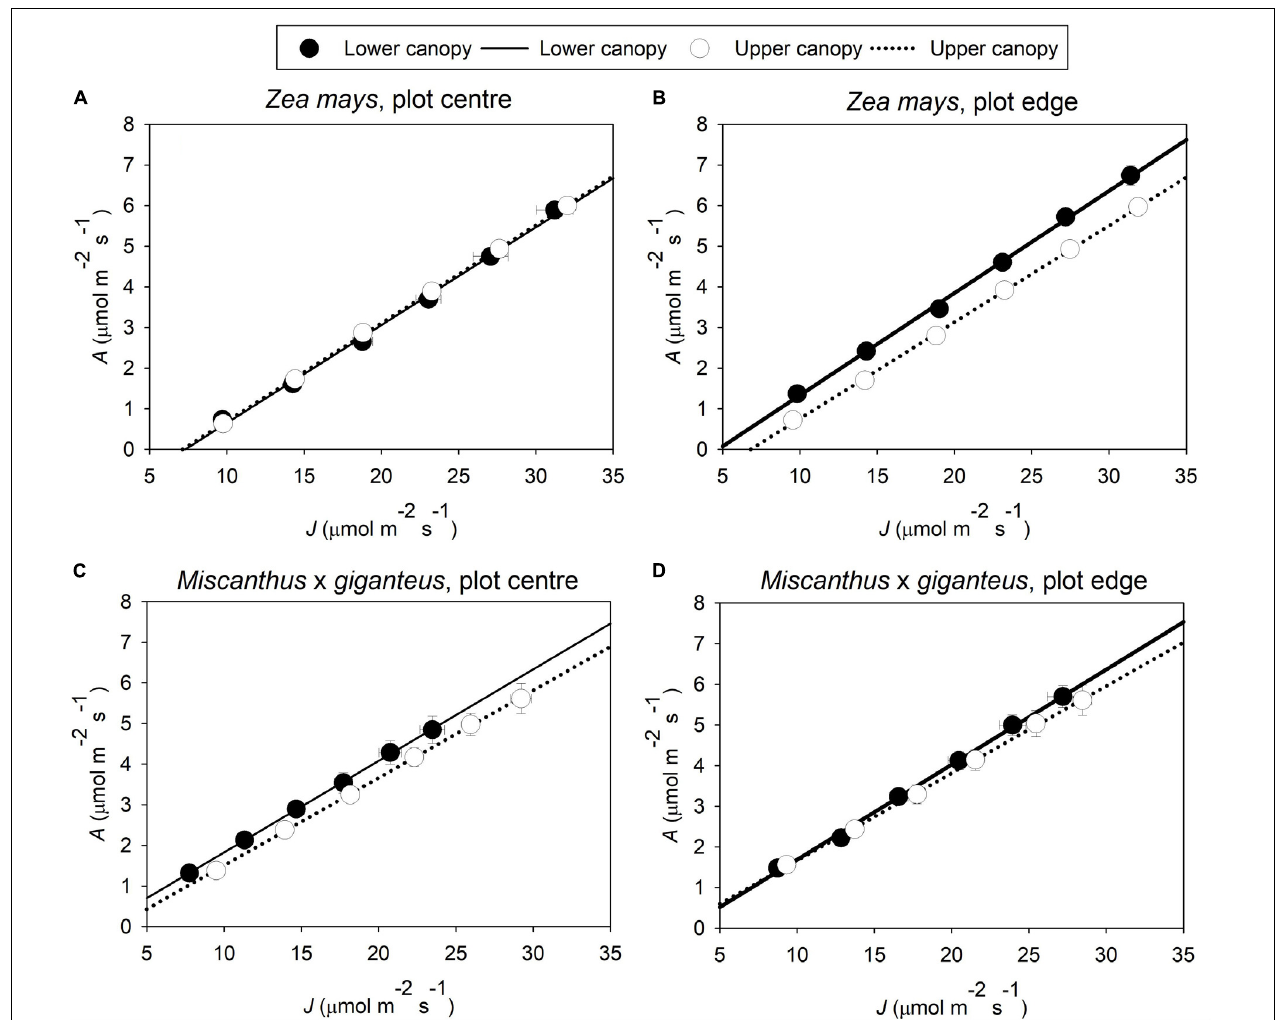
FIGURE 3 | Average linear responses of A to J in (A) Z. mays in plot centre and (B) plot edge; and (C) M. x giganteus in plot centre and (D) plot edge ( n = 8–16). Data is from light-limited measurements ( PPFD from 40 to 140 µ mol m − 2 s − 1 ). Symbols give the mean A ± s.e. and mean J ± s.e. at each level of PPFD . Lines give the best-fit linear regression; the slope of this regression gives the trait 1/ k